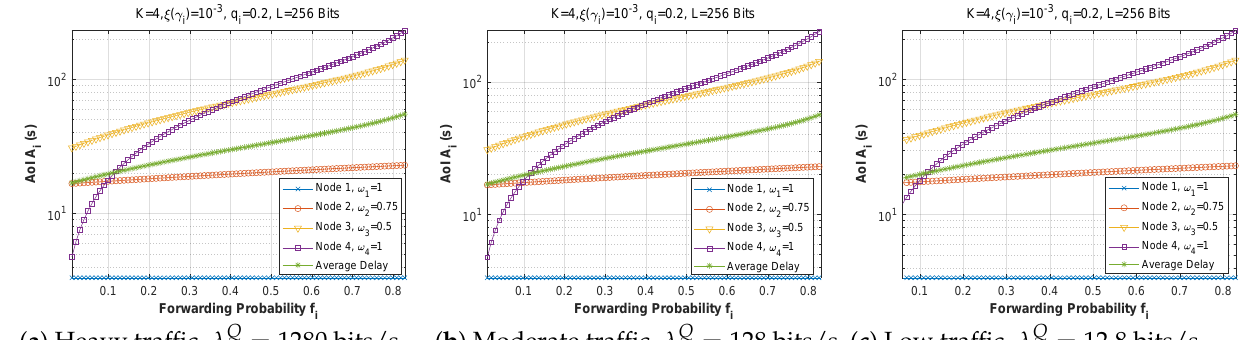
Figure 23. Setting 2: The AoI experienced at each mobile device as a function of forwarding probabil- ity f i for various values of the arrival rate λ Q